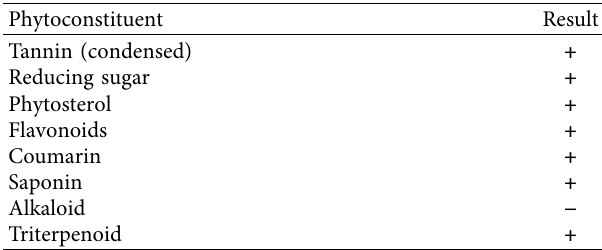
Table 1: Phytochemical screening of the stem bark of A. macrostachya